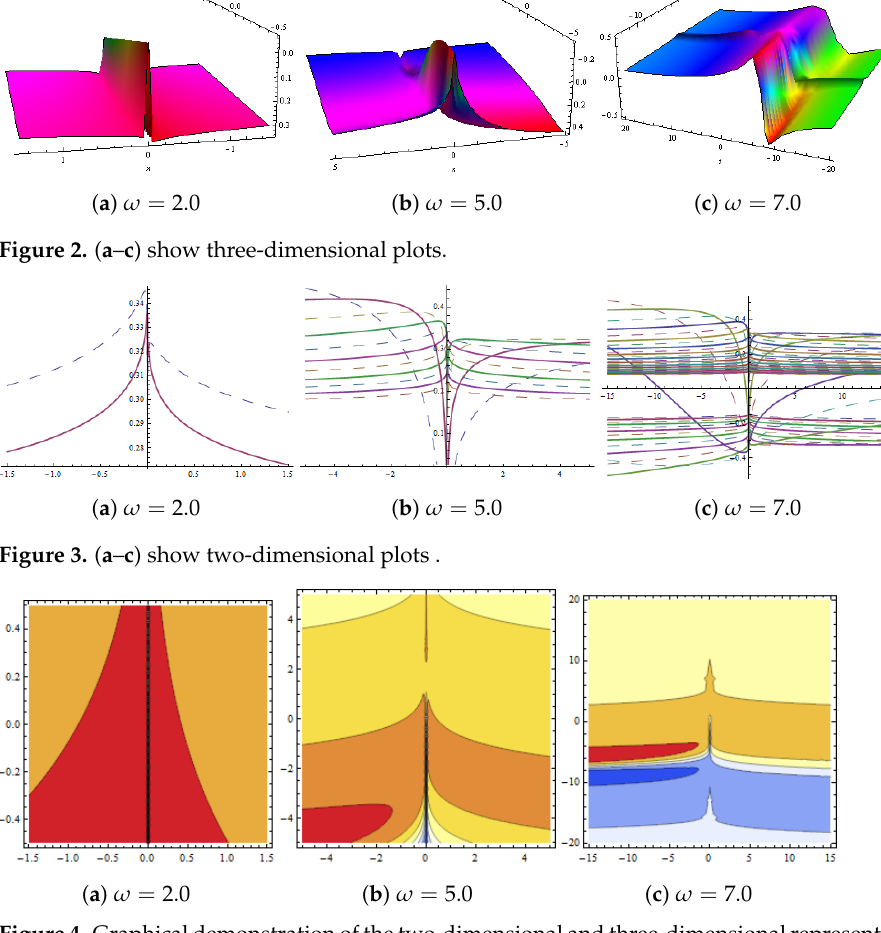
Figure 4. Graphical demonstration of the two-dimensional and three-dimensional representations and contour of solution v ( x , t ) in Equation (21) with β 2 = 0.2, β 3 = 3.5, ζ = 0, l 2 = 0.03, Q = 5, r 1 = 2.5, w 2 = 5, w 3 = 0.3, w 4 = 0.9, and φ = 1.7. ( a – c ) show contour graphs.